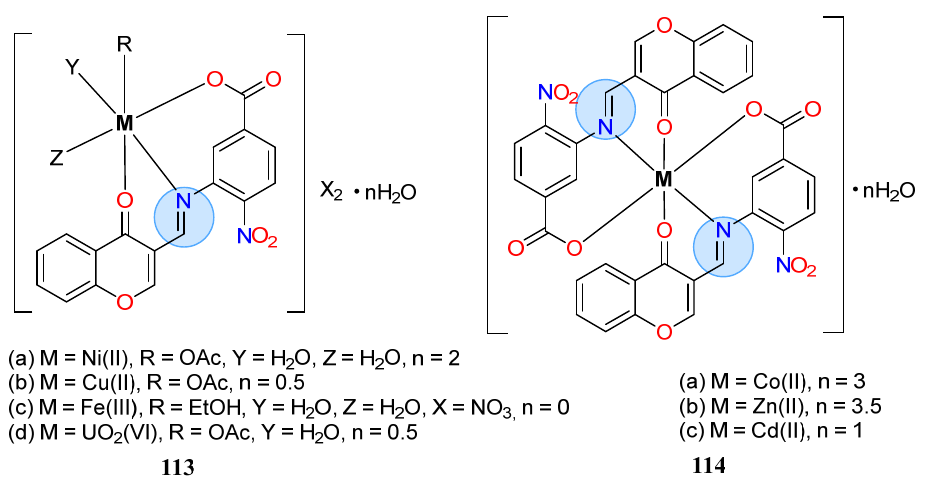
Figure 59. A Schiff base derived from chromene and its transition-metal complexes. The SB ligand named 2 ‐ (2 ‐ hydroxy ‐ 3 ‐ methoxybenzylidene) ‐ N ‐ (4 ‐ phenylthiazol ‐ 2